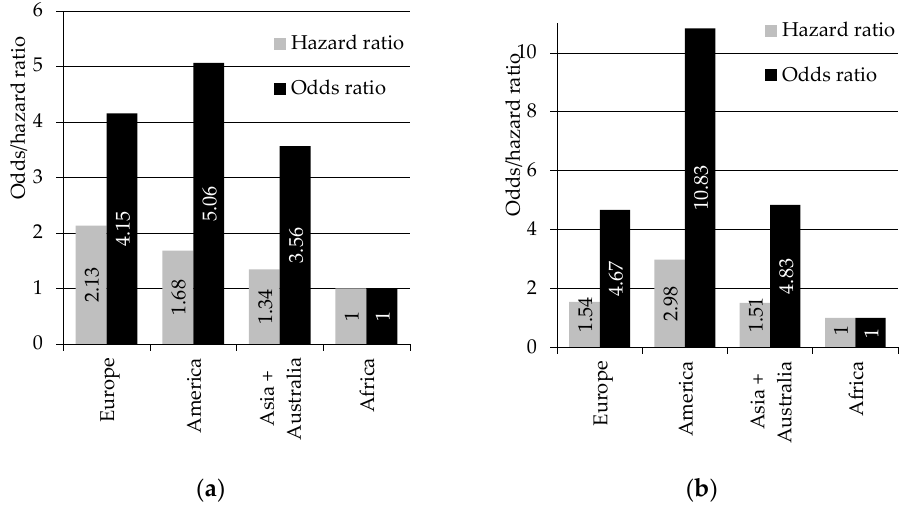
Figure 9. The risk and intensity of the decline ( a ) and increase ( b ) of stock indices by continent. Source: own elaboration, Statistica.